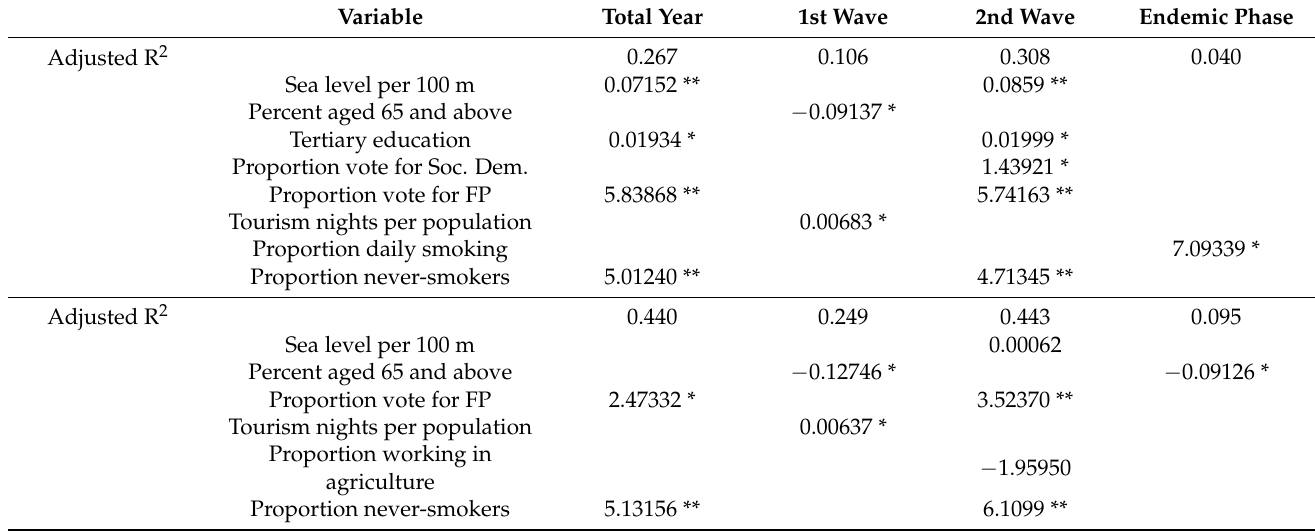
The total number of COVID-19 deaths amounted to (mean ± std. dev.) 92.09 ± 36.88 per 100,000. The respective number in the first wave was 6.19 ± 6.95, in the second wave 81.85 ± 35.38, and in the endemic phase between the two waves 1.44 ± 1.84. The final regression models for mortality are shown in Table 3, with and without consideration of federal country. Univariate correlation coefficients for all independent variables with the natural logarithms of cumulative deaths can be found in Appendix A (Table A2). Both percentage of never-smokers and of voters of the right-wing populist party (FP) were consistently associated with higher risks of COVID-19 deaths. For example, in the adjusted model, an increase in voters of the right-wing populist party by 1.6 percentage points is associated with an increase in cumulative mortality by 10% (federal country not considered). Figure 5 illustrates the connection between right-wing voters (left) and never-smokers (right) with lethality (left) and mortality (right) in a scatterplot. Table 3. Coefficients of the final linear regression model for ln (deaths + 1). Upper part: federal country not considered; lower part: federal country